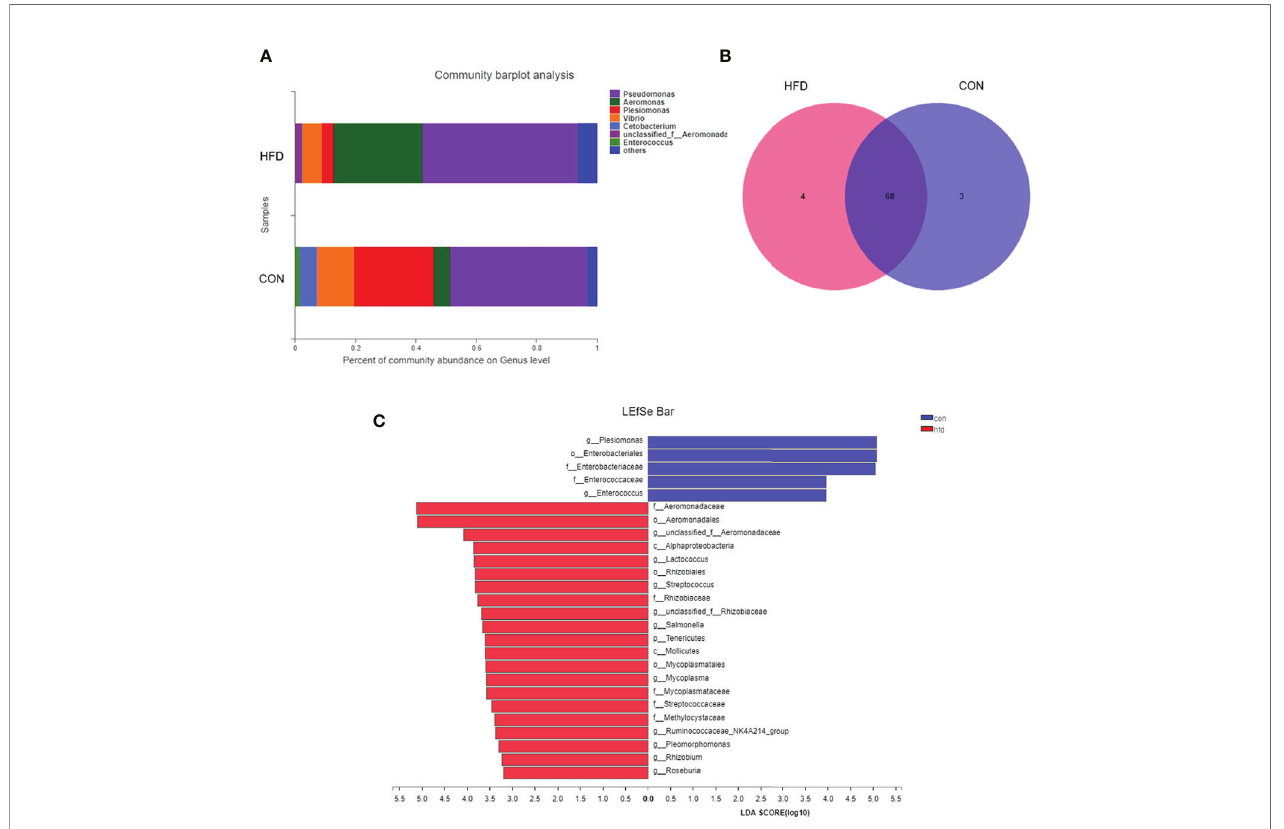
FIGURE 4 | Differences in intestinal microbial composition after High-fat diet-induced obesity. (A) Composition of intestinal microbial communities in the control and obese groups. (B) Venn plot population analysis results in gut microbes between the control and obese groups. (C) LEfSe multi-level species discriminant analysis using non-parametric factorial Kruskal – Wallis rank sum test and LDA to fi nd groups that signi fi cantly differ in abundance. Data represent mean ± SME ( n =